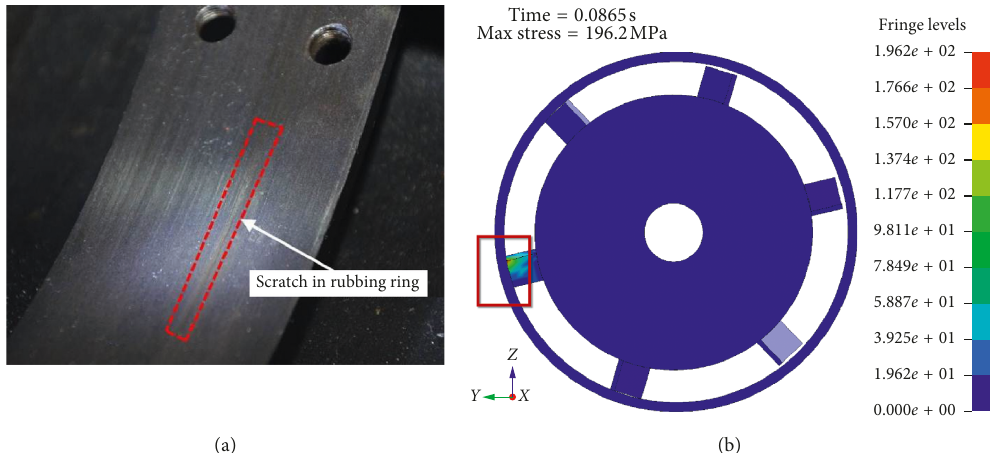
Figure 7: Results of light rub-impact condition. (a) Scratch on rubbing ring. (b) Von Mises stress distribution.